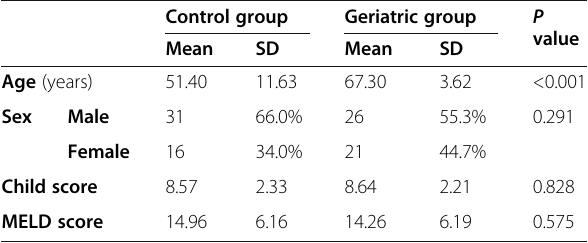
Table 1 Demographic data, Child and MELD scores of all study population Control group Geriatric group